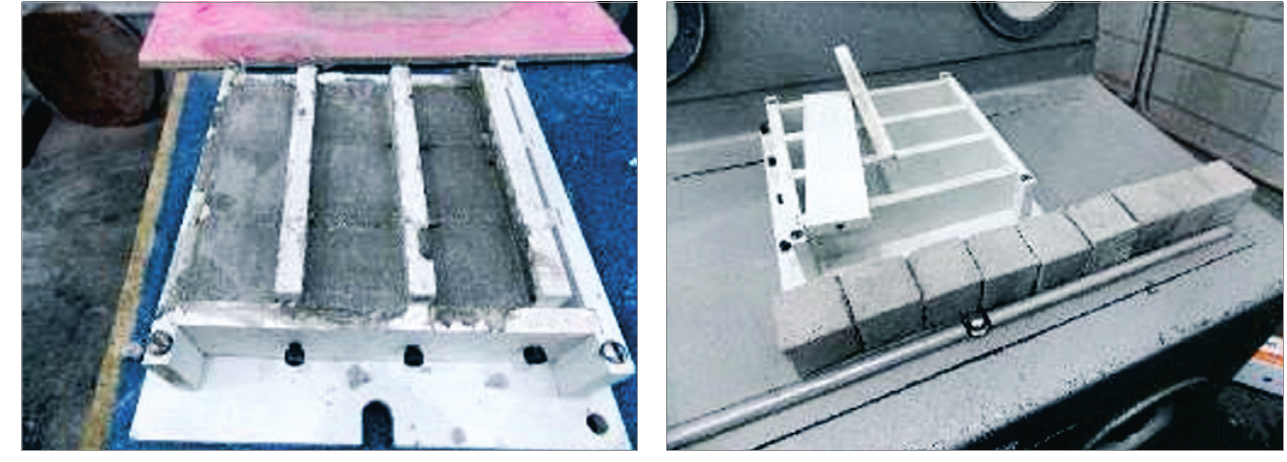
Figura 3 Moldagem dos corpos-de-prova cubicos de argamassa Tabela 6 Denominações dos grautes, traços e resistências esperadas